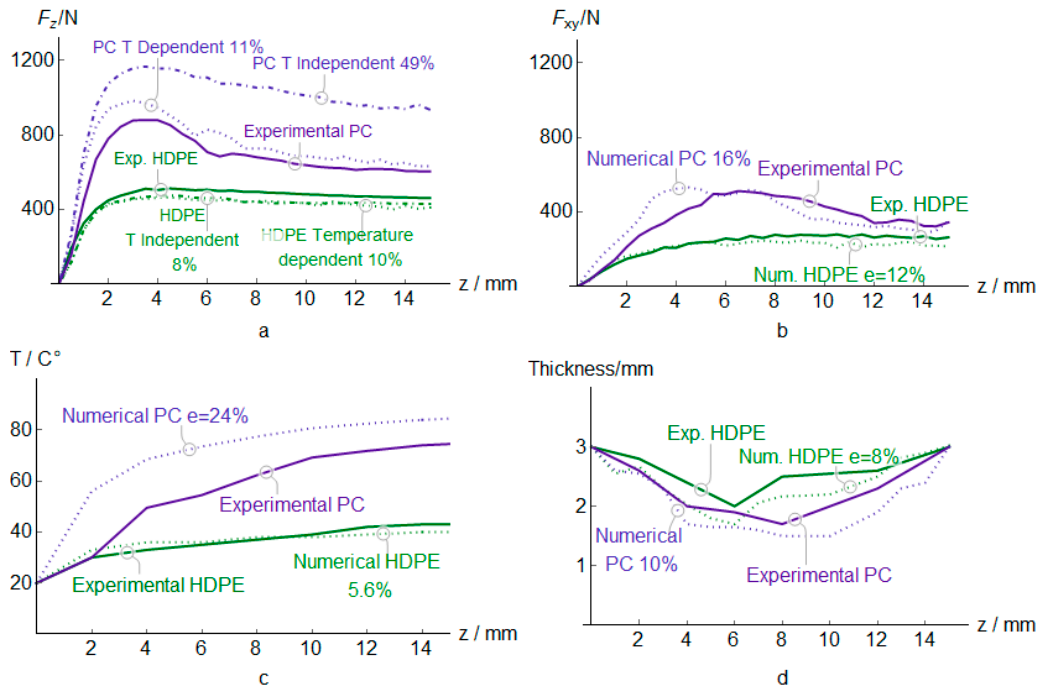
Figure 15. Force F z , F xy ( a , b ), temperature ( c ), and thickness ( d ) estimations for PC and HDPE sheets.